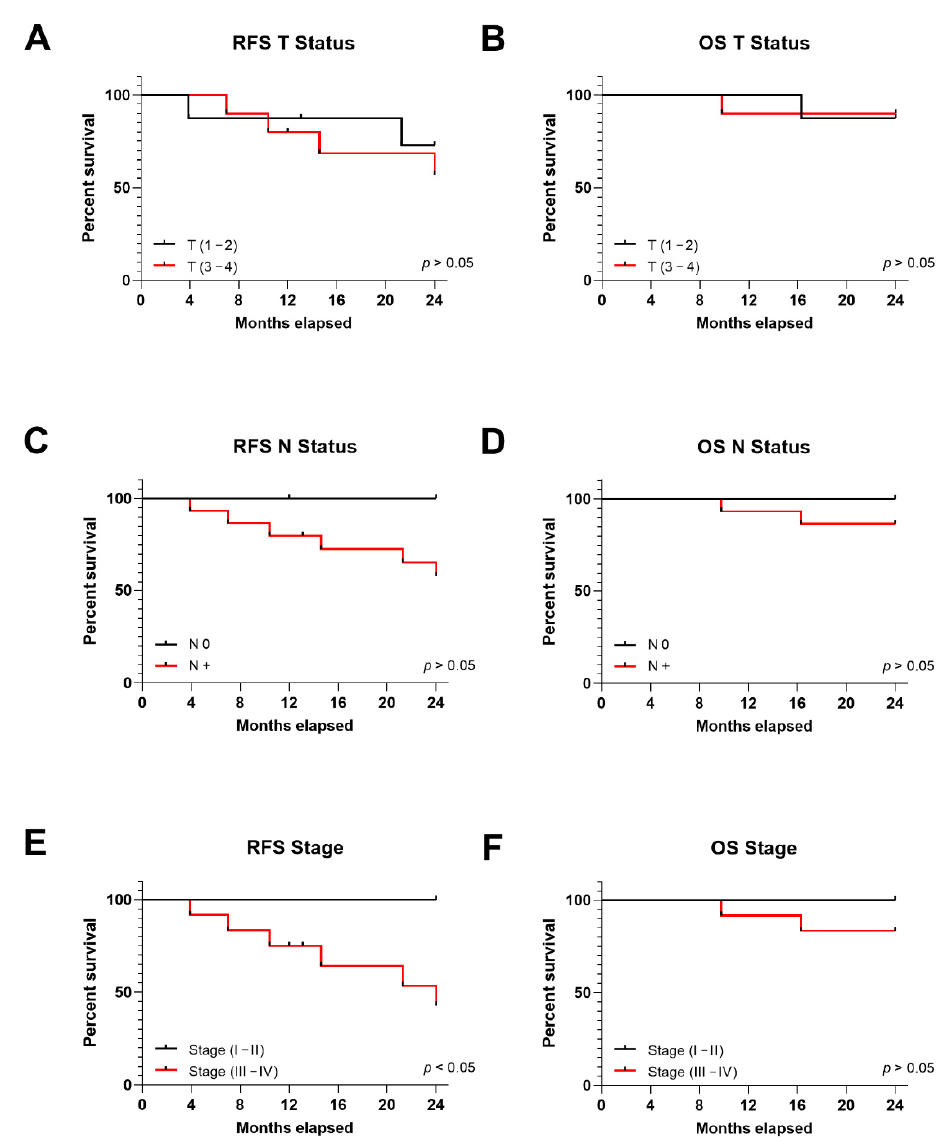
Figure 5. Kaplan-Meier (KM) curves for tumor size (T), node status (N) and stage in HPV-positive HNSCC patients representing RFS and OS; KM representing ( A ) RFS and ( B ) OS for patients divided into tumor size: T (1–2) and T (3–4); KM representing ( C ) RFS and ( D ) OS for patients divided into node status: N0 and N+; KM representing ( E ) RFS and ( F ) OS for patients divided into stages I/II and III/IV; OS for patients divided into stages I/II and III/IV. Statistical significance was indicated as p <